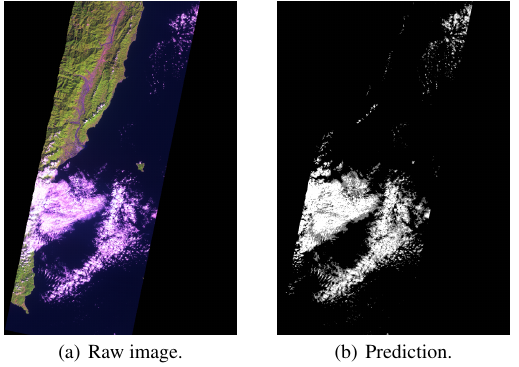
Figure 16. Cloud segmentation prediction